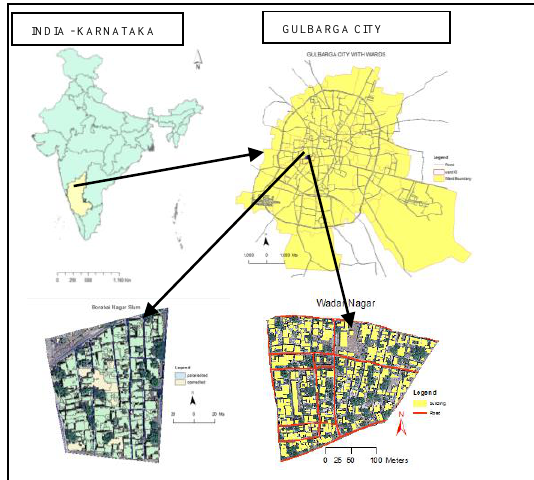
Figure 5 Gulbarga city – slum case studies